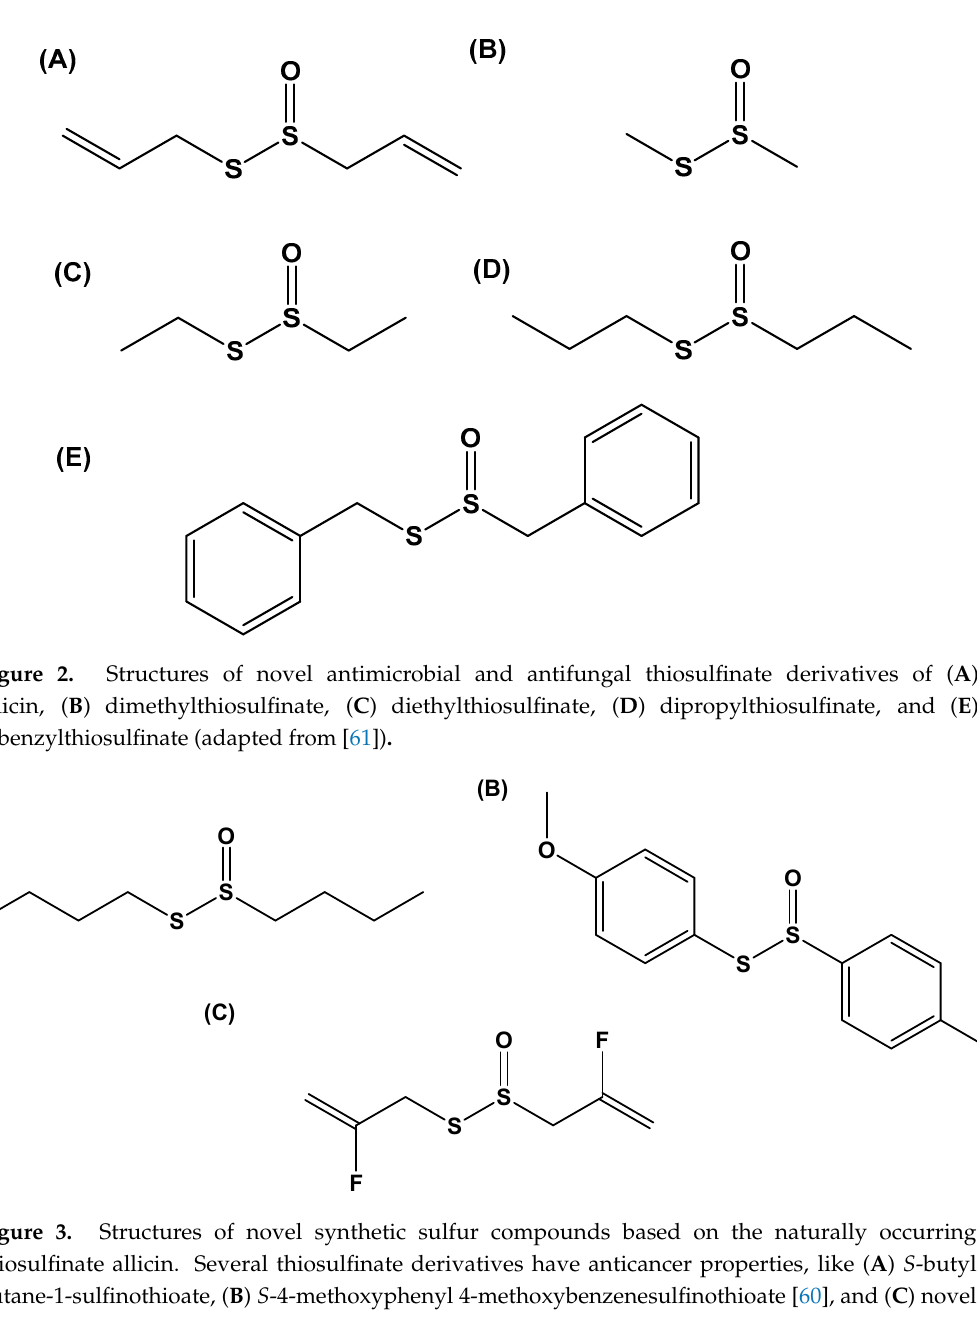
Figure 3. Structures of novel synthetic sulfur compounds based on the naturally occurring thiosulfinate allicin. Several thiosulfinate derivatives have anticancer properties, like ( A ) S -butyl butane-1-sulfinothioate, ( B ) S -4-methoxyphenyl 4-methoxybenzenesulfinothioate [60], and ( C ) novel antithrombotic agent difluoroallicin [61].